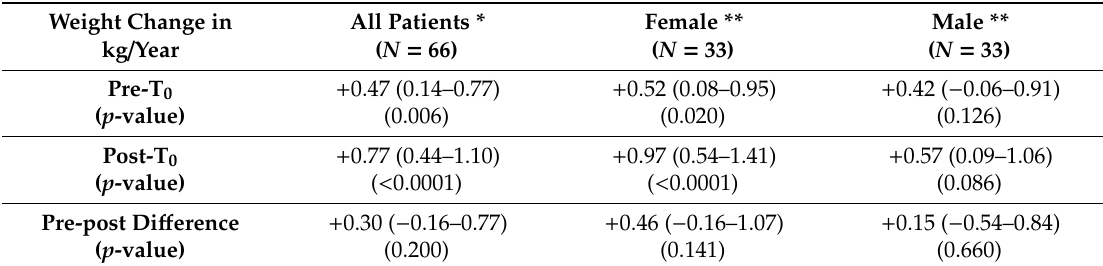
Table 2. Annual rate of weight change pre and post the time of the switch (T 0 ) to integrase strand transfer inhibitor (INSTI). For the non-INSTI group T 0 was randomly assigned, assuming that the weight change was constant over the study